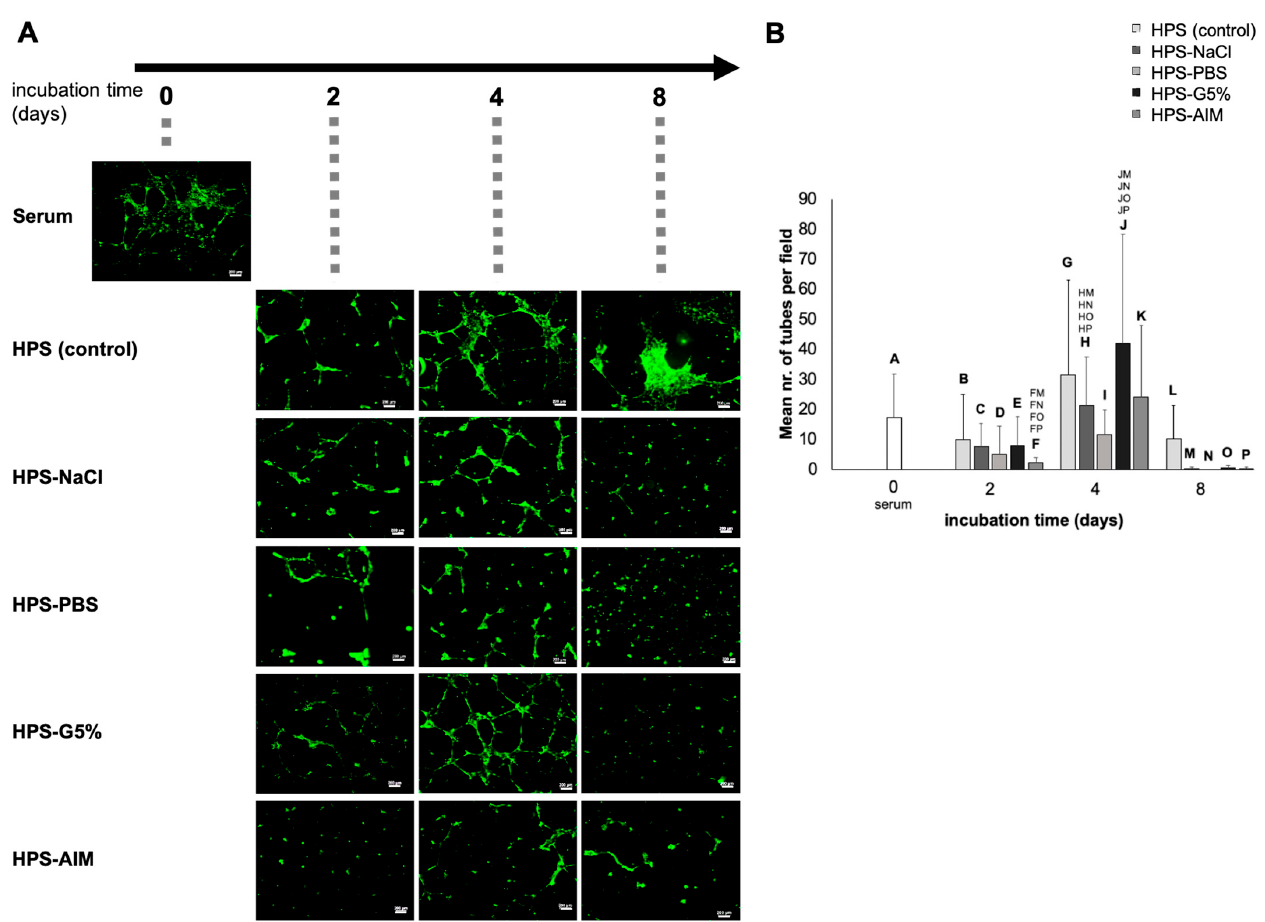
Figure 5. Effect of various coagulated blood-derived hypoxia preconditioned media on microvessel formation in endothelial cell cultures in vitro. ( A ) Panel showing representative images of the tube formation assay (12 h culture duration), carried out in the presence of coagulated blood-derived secretomes (fresh serum; hypoxia preconditioned serum (HPS)) and four different hypoxia preconditioned serum substitutes: normal saline (HPS-NaCl), hypoxia preconditioned phosphate buffered saline (HPS-PBS), hypoxia preconditioned Glucose 5% (HPS-G5%), and hypoxia preconditioned AIM medium (HPS-AIM). Blood samples were obtained from 4 young, healthy subjects and conditioning was carried out over 2, 4, and 8 days prior to testing. Scale bars = 200 μ m. ( B ) Plot showing the mean number of tubes formed in HUVEC cultures that were incubated for 12 h with coagulated blood-derived secretomes, as described in ( A ). Blood donors: n = 4. Two-way repeated measures ANOVA with Tukey’s multiple comparison test. Data points are means ± SD. Capital letter pairs over plots indicate statistical comparison of corresponding data points unless otherwise indicated.